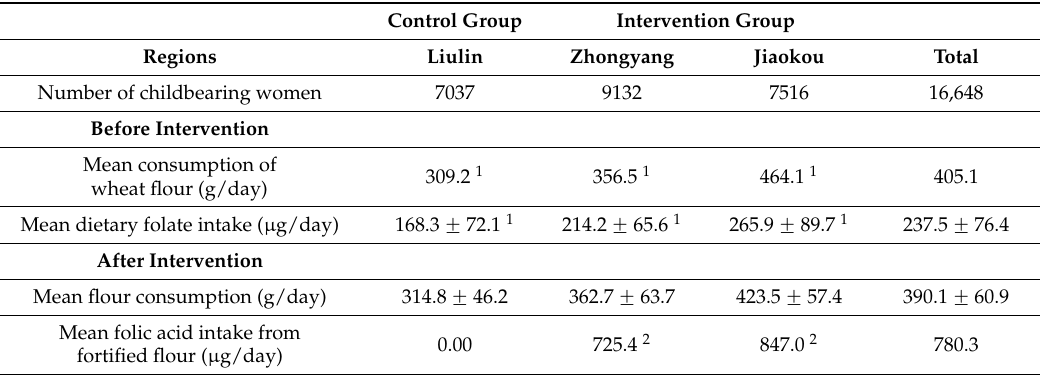
Table 2. Mean daily dietary folate intake in the control and intervention group (before and after the